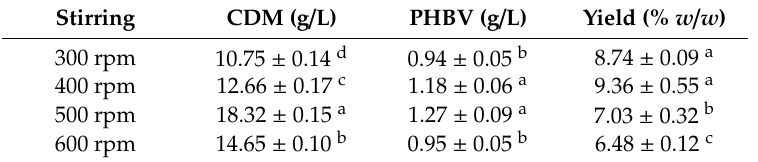
Table 2. CDM, PHBV production and yield obtained after 72 h of fermentation in bioreactor system.